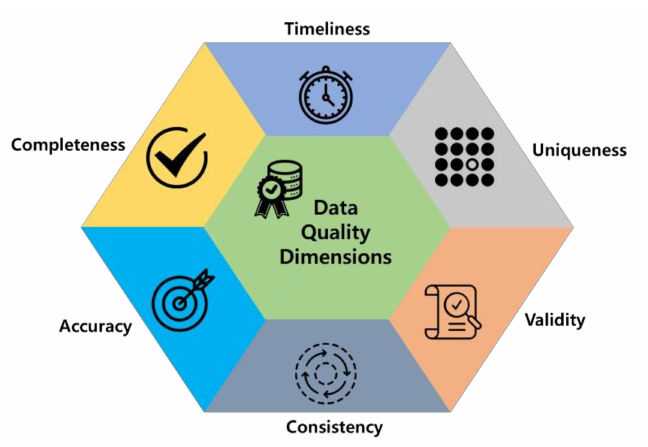
Figure 1. Data quality dimensions